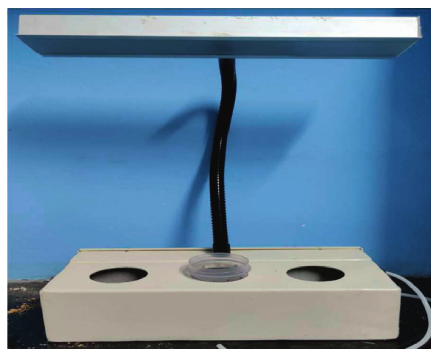
Figure 26: The device.